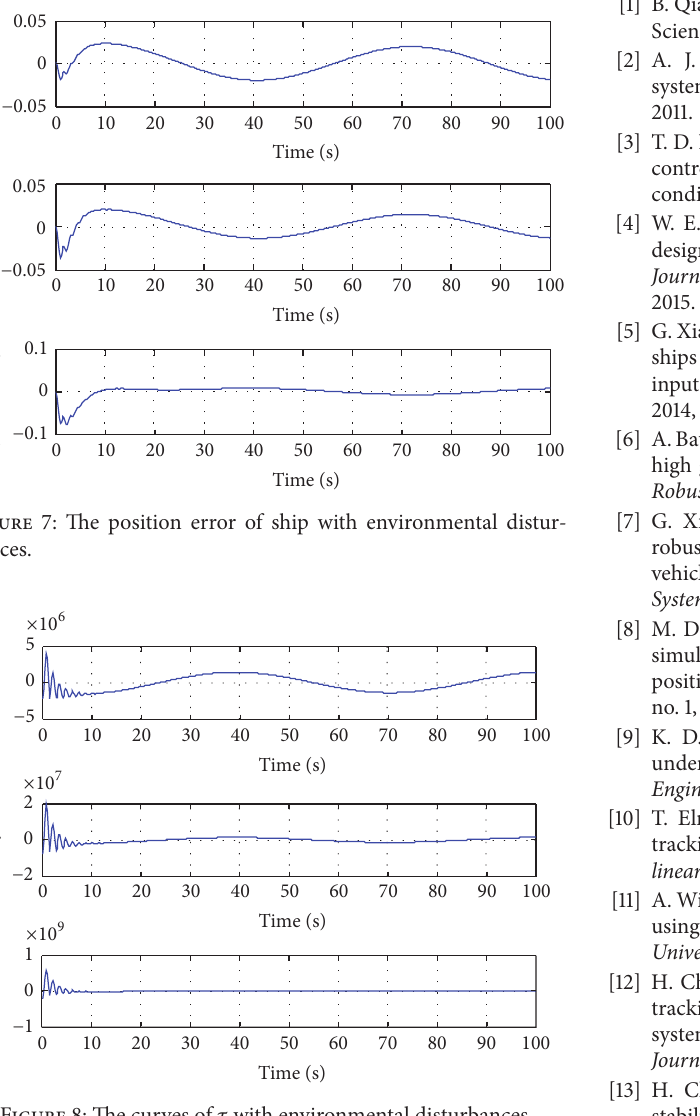
Figure 8: The curves of 𝜏 with environmental